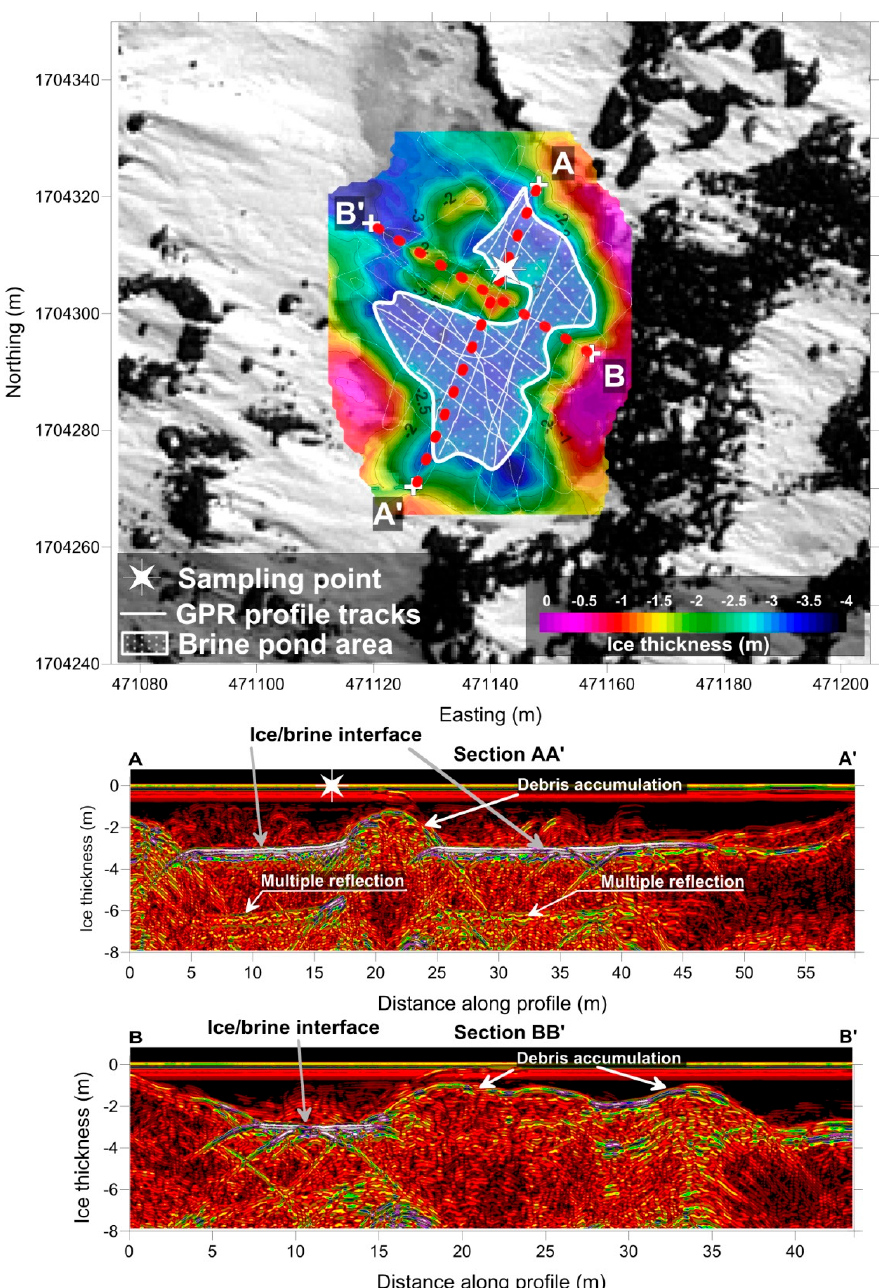
Figure 10. Lake-Ice Blister thickness map with representative cross-section radargrams.